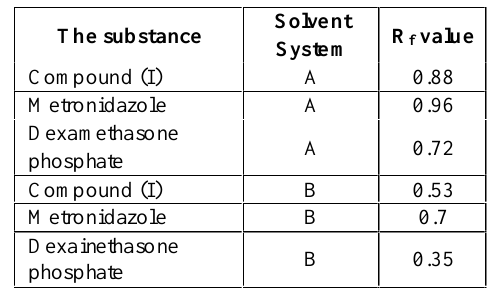
Table 1: The R f values for the reactants